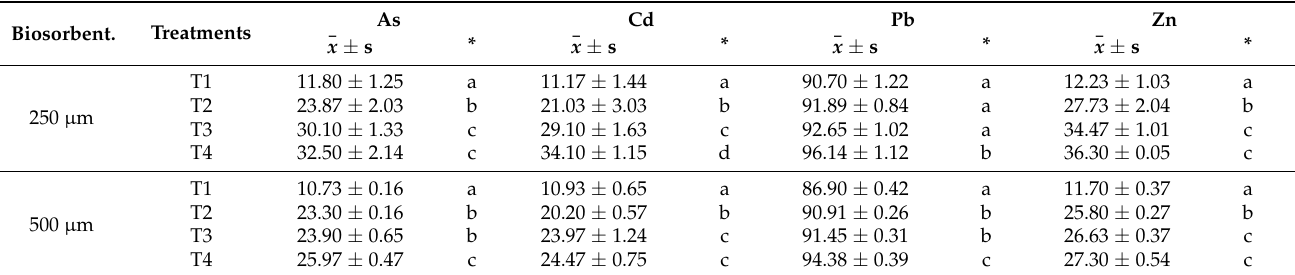
Table 3. Heavy metal removal (%).